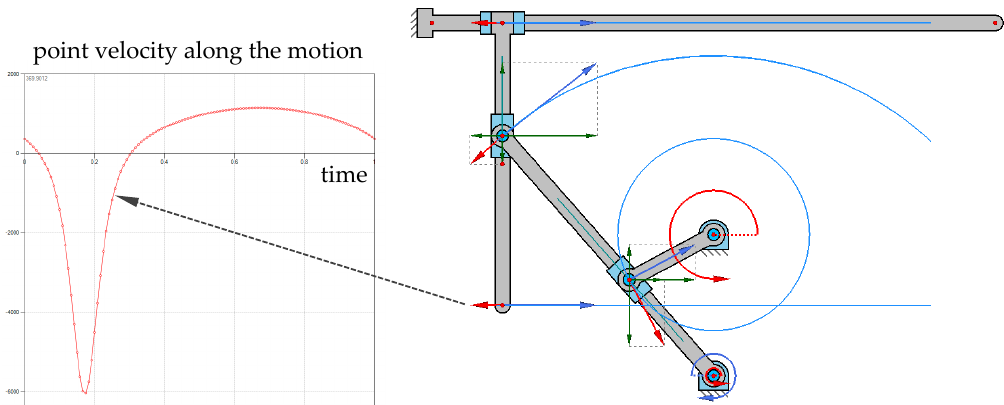
Figure 6. Main kinematic results: Trajectories, velocities, and accelerations for given inputs.